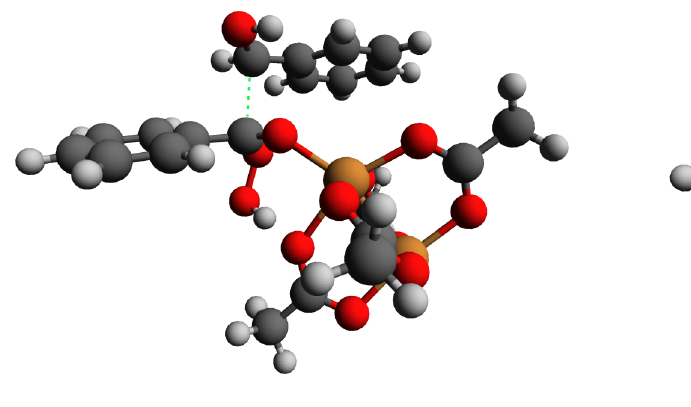
15 of 23 Figure 16. RSS energy profiles of ( a ) the HOO − attack and ( b ) the rearrangement. Each point de- picts the energy of the species yielded by the constrained optimization with the corresponding constraint value imposed to the scanned distance. The connecting lines were added solely for guiding the eye. It should be explicitly indicated that this value represented the difference in the electronic energies rather than the difference in Gibbs free energies, and therefore it could serve only as a rough estimate of the principal possibility of the Baeyer–Villiger pathway for this process. The value of 160 kJ/mol was quite a high barrier, which was significantly higher than the typical values of Baeyer–Villiger reaction barriers reported previously (e.g., 84 kJ/mol for furfural oxidation by H 2 O 2 of sulfated zirconia [71]). The reaction rate, 𝑘 , decreased exponentially with the increase in the barrier height, Δ𝐺 ‡ , ac- cording to the Eyring equation, Equation 2 [72]. G B RT k T k e h κ + + −Δ = (2) where Δ𝐺 ‡ is the Gibbs activation energy, 𝜅 is the transition coefficient and 𝑘 (cid:3003) and ℎ are the Bolzmann and Plank constants, respectively. Assuming 𝜅 = 1 , and considering the studied elementary step to be a first-order process, we can estimate the half-life value for the 160 kJ/mol barrier and 293 K as ca. 120 mln. years. On the contrary, considering 24 h as the maximal practically acceptable half-life, one can estimate the corresponding Δ𝐺 ‡ as no more than ca. 100 kJ/mol. In order to elucidate if there could be other reaction paths with lower energy barri- ers, we applied a search of the transition state between the two considered geometries via a Climbing Image Nudged Elastic Band (NEB-CI) procedure (see the Experimental